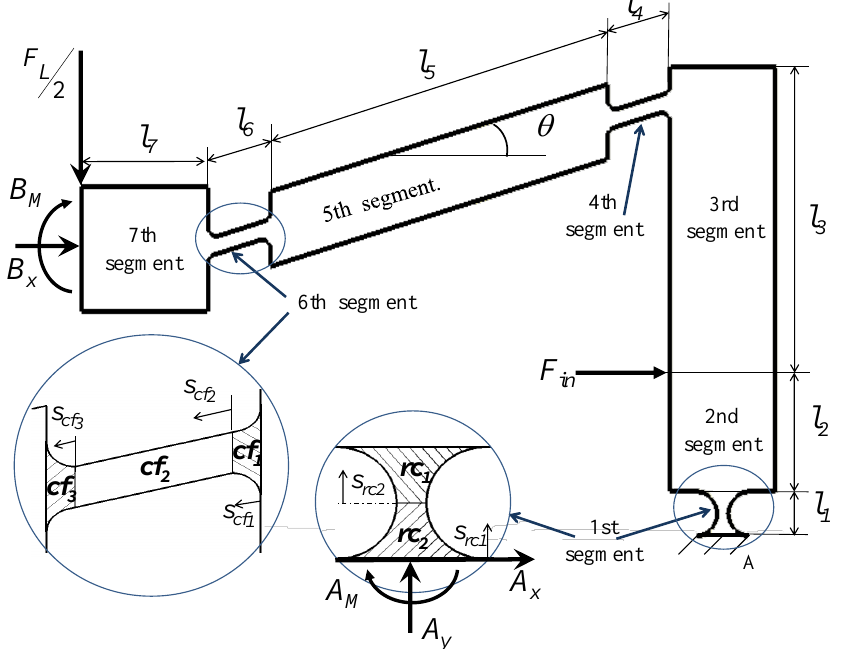
Figure 3. Free body diagram of the mechanism, showing dimensions, forces, and mechanism segments “ i